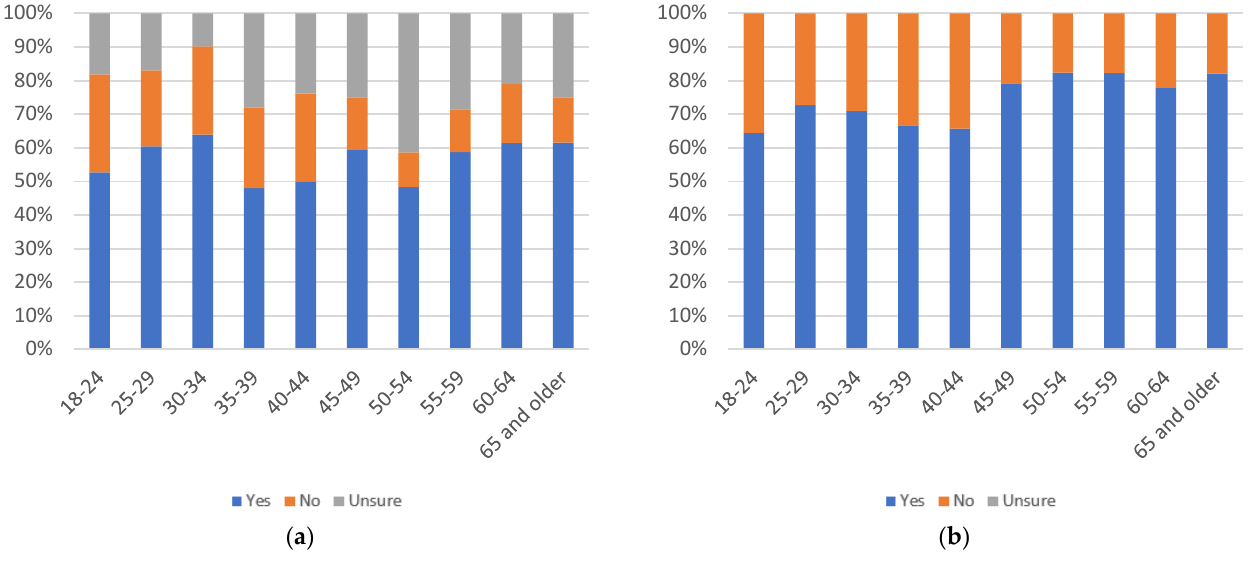
Figure 62. Label others’ use, by age group: ( a ) with uncertain respondents (left) and ( b ) without uncertain respondents (right).